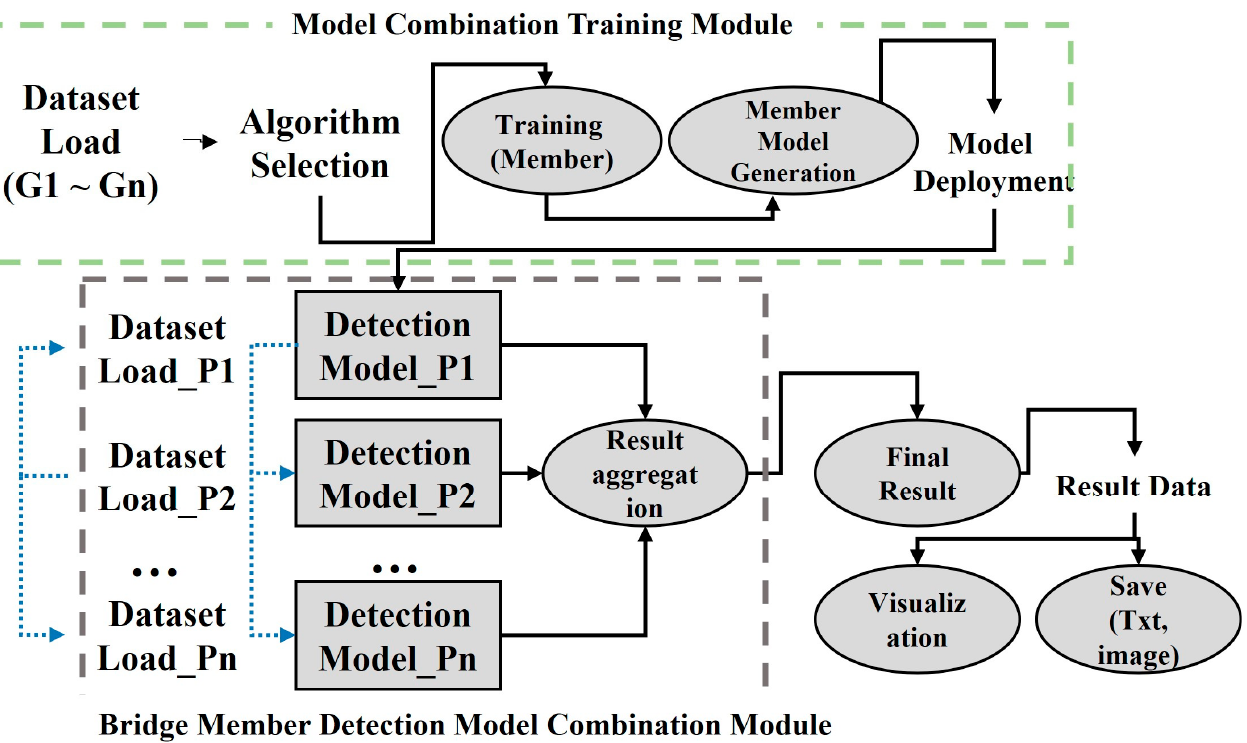
Figure 6. Concept of combined detection model framework by members.